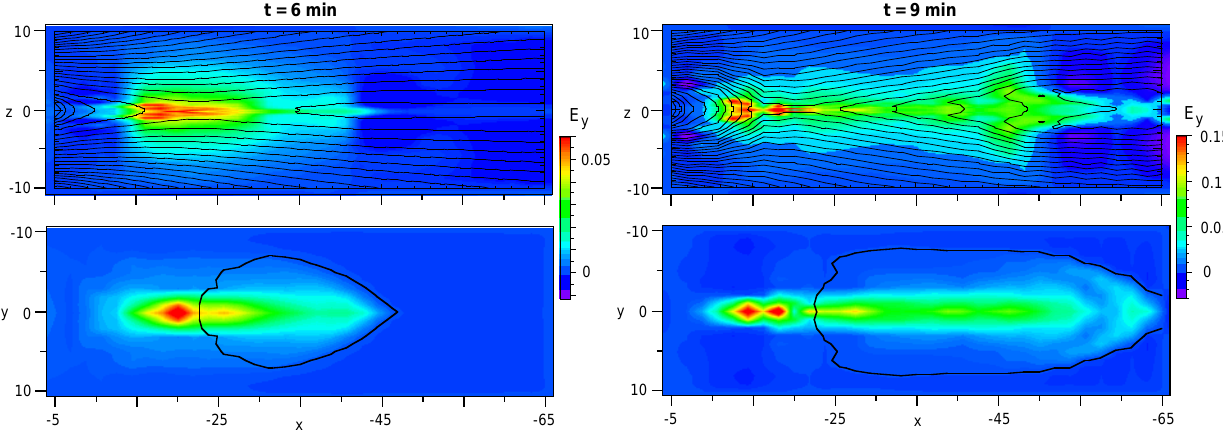
Fig. 1. Color-coded cross-tail electric field E y obtained from the MHD simulation (Birn and Hesse, 1996) at two different times, as indicated. The top panels show E y , at y = 0, together with magnetic field lines, the bottom panels show E y at z = 0, together with the magnetic neutral line. The near-Earth part of the neutral line represents the x-line at the reconnection site, whereas the tailward part is the o-line in the center of the plasmoid, propagating tailward with the plasmoid. Note that the color scale for E y is different for the different times. The electric field unit corresponds to ∼